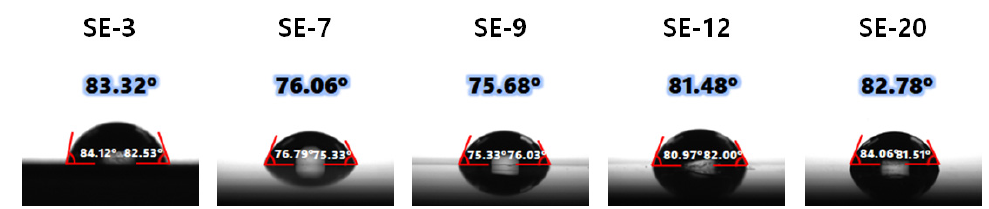
Figure 6. Images of the measured water contact angles on steel sheets degreased with the various degreasing solutions for 1 min at 40 °C.